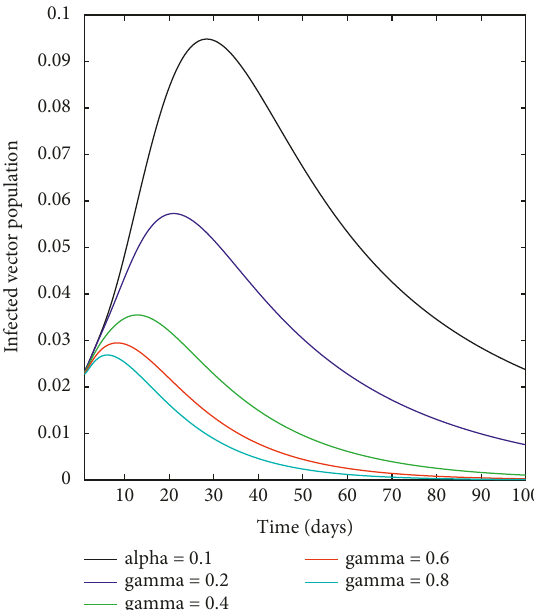
Figure 18: Increasing recovery rate with α �